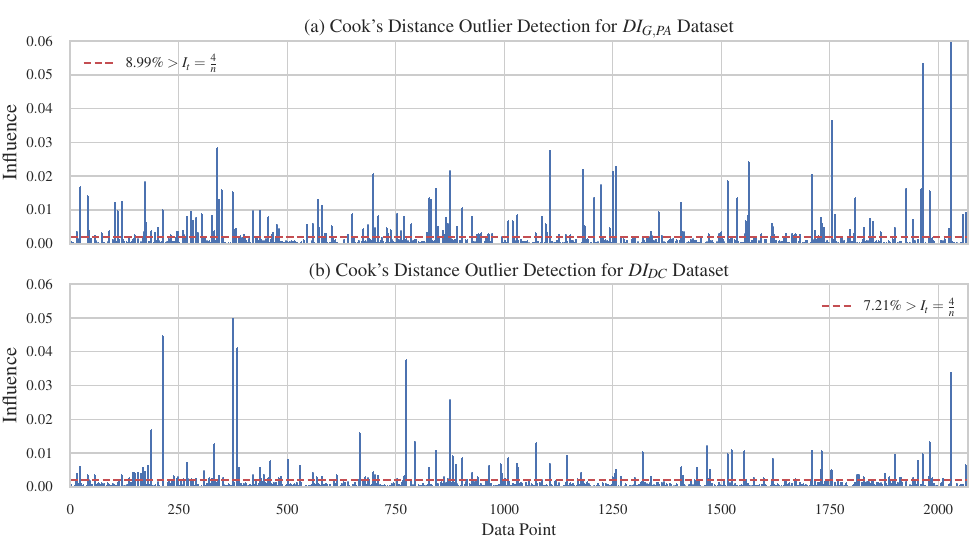
Figure 5. Cook’s distance of each data point for ( a ) the DI G,PA dataset and ( b ) the DI DC